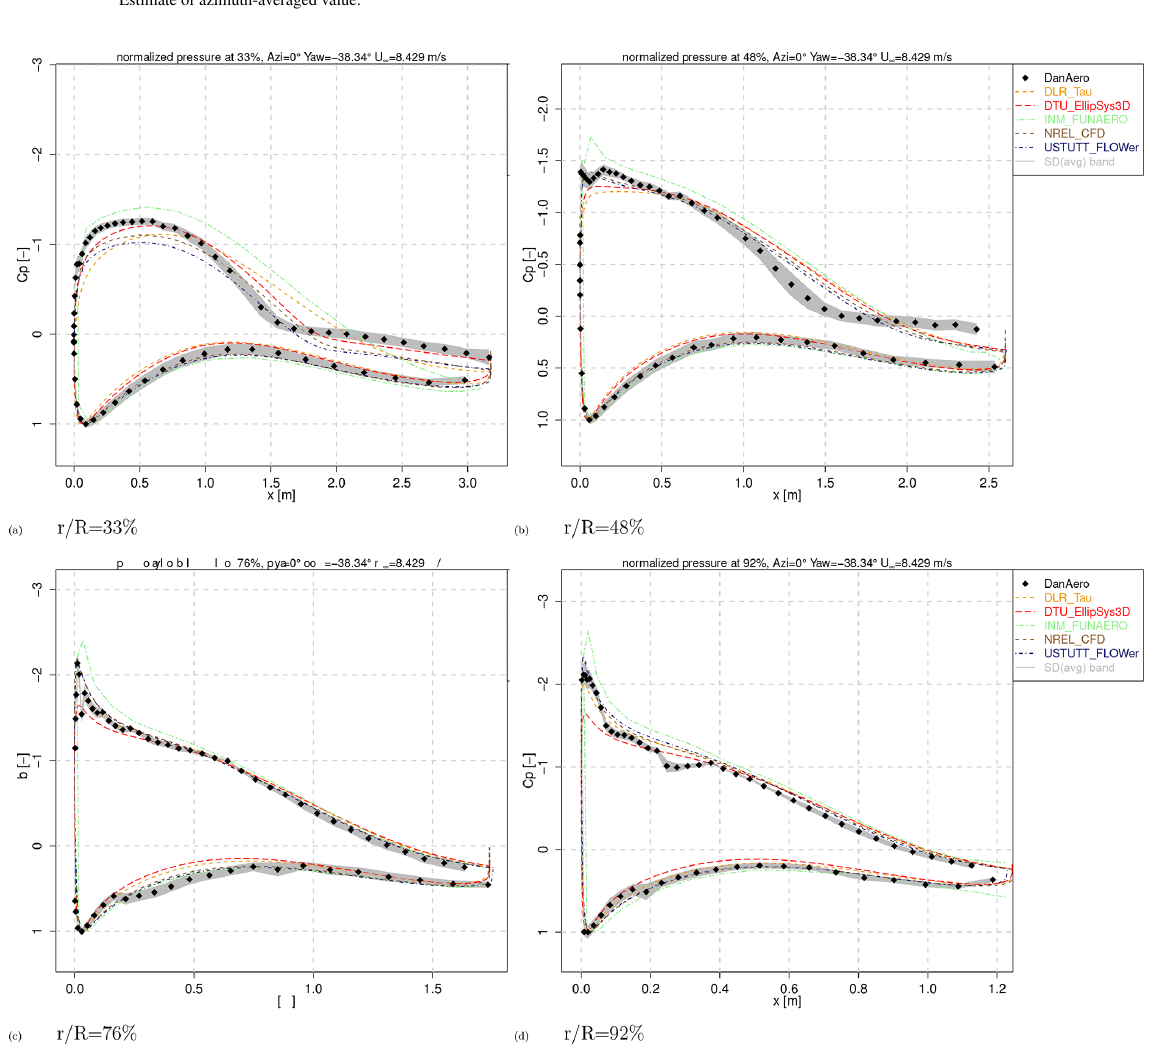
Figure 8. Pressure distribution comparison at a 0 ◦ azimuth angle, Case IV.2.2. Animations of variation with an azimuth angle are available from the